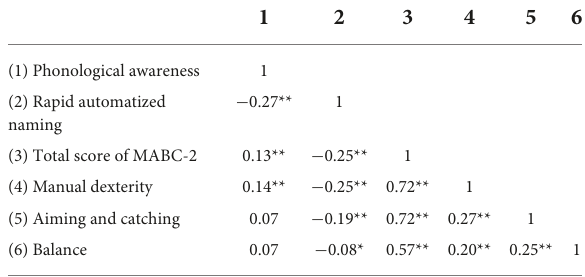
TABLE 3 Pearson partial correlation coefficients relating the children’s scores on the phonological awareness test and their scores on the rapid automatized naming test to their scores on the motor test, after the C-TONI-3 and C-PPVT-R scores were